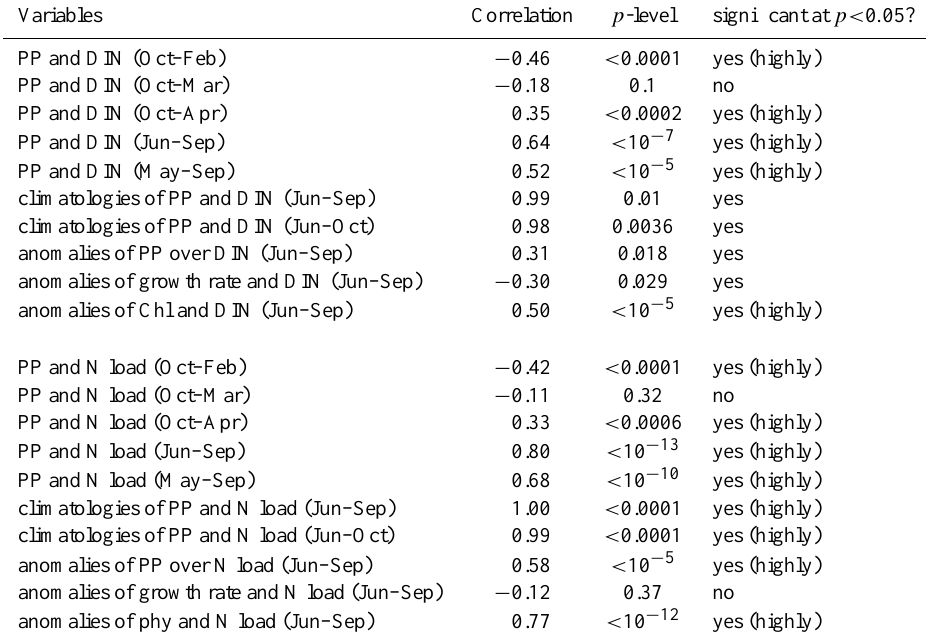
Table 1. Linear correlation coefficients and p -levels for the delta